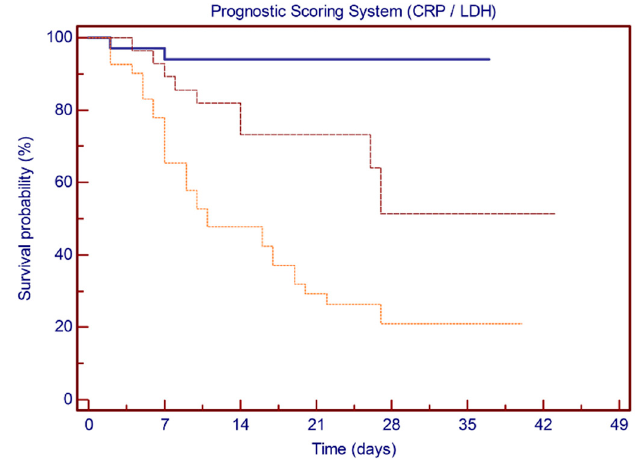
Figure 5. Kaplan–Meier plots showing the probability of survival based on the prognostic score